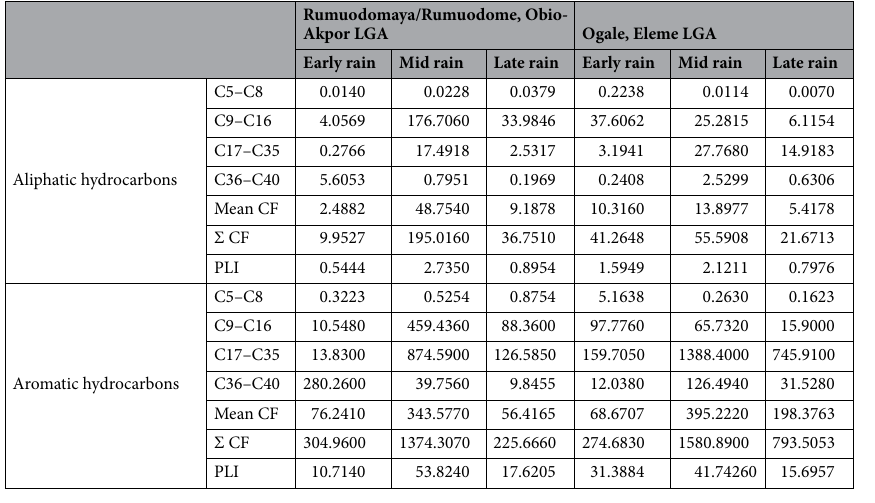
Table 4. Contamination Factor and Pollution Load Index of Petroleum hydrocarbons